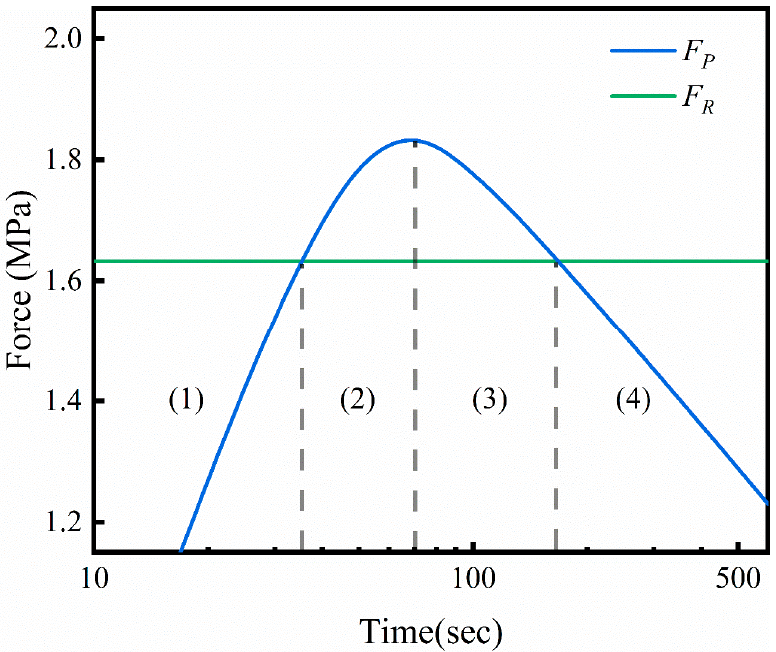
Figure 10. Evolution of recrystallization driving force F R and precipitation pinning force F P during stress relaxation at 900 °C for Ti microalloyed steel.